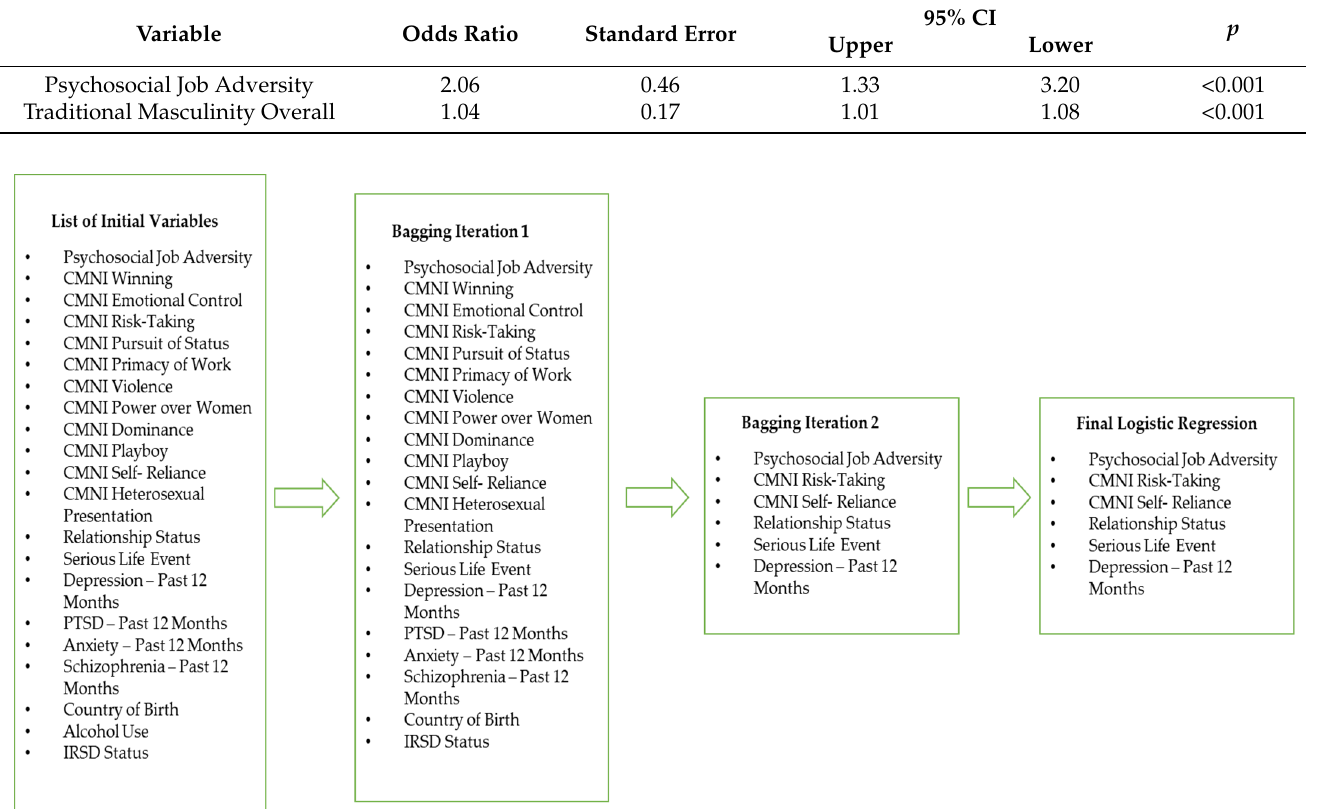
Table 3. Multivariate Logistic Regression Assessing Associations between Suicidal Ideation, Mas- culinity Domains of Self-Reliance, Risk Taking and Psychosocial Job Adversity. Variable